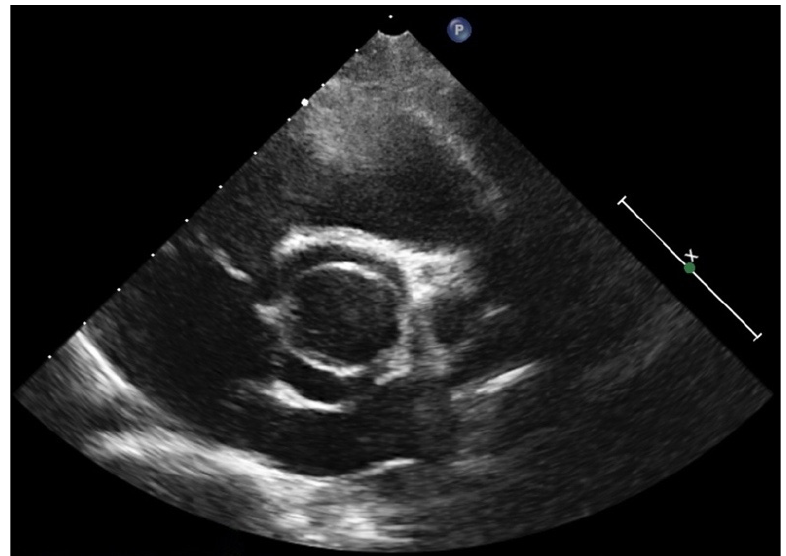
Figure 1. 2D Echocardiography parasternal short axis view (systolic frame) at the level of aortic valve shows a bicuspid aortic valve in an 8-year-old patient.